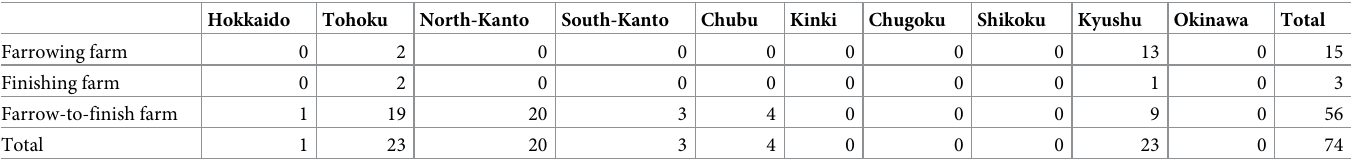
from prodrug content to active ingredient (e.g. from procaine penicillin to penicillin), the same conversion factors as used by ESVAC were employed [17,18]. Use of penicillins was quantified for different subclasses as well (beta-lactamase sensitive penicillins and penicillins with extended spectrum). Table 1. Geographical distribution and distribution by farm type of the 74 pig farms subjected to the analysis in this study. Hokkaido